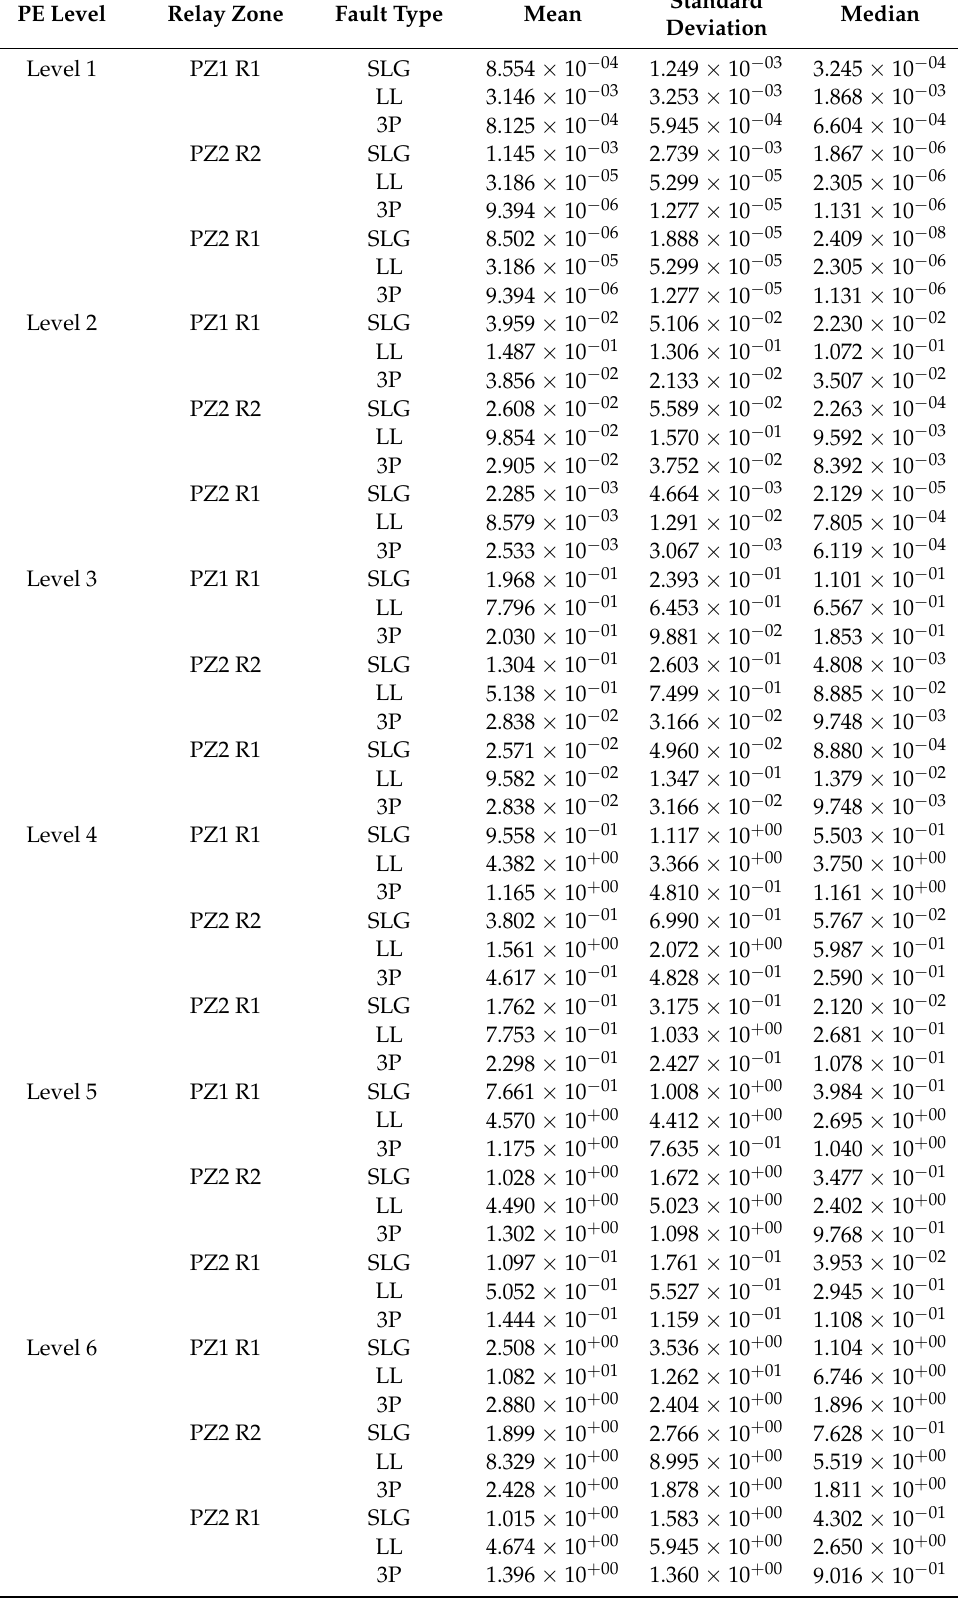
Table A6. PE values aerial 1